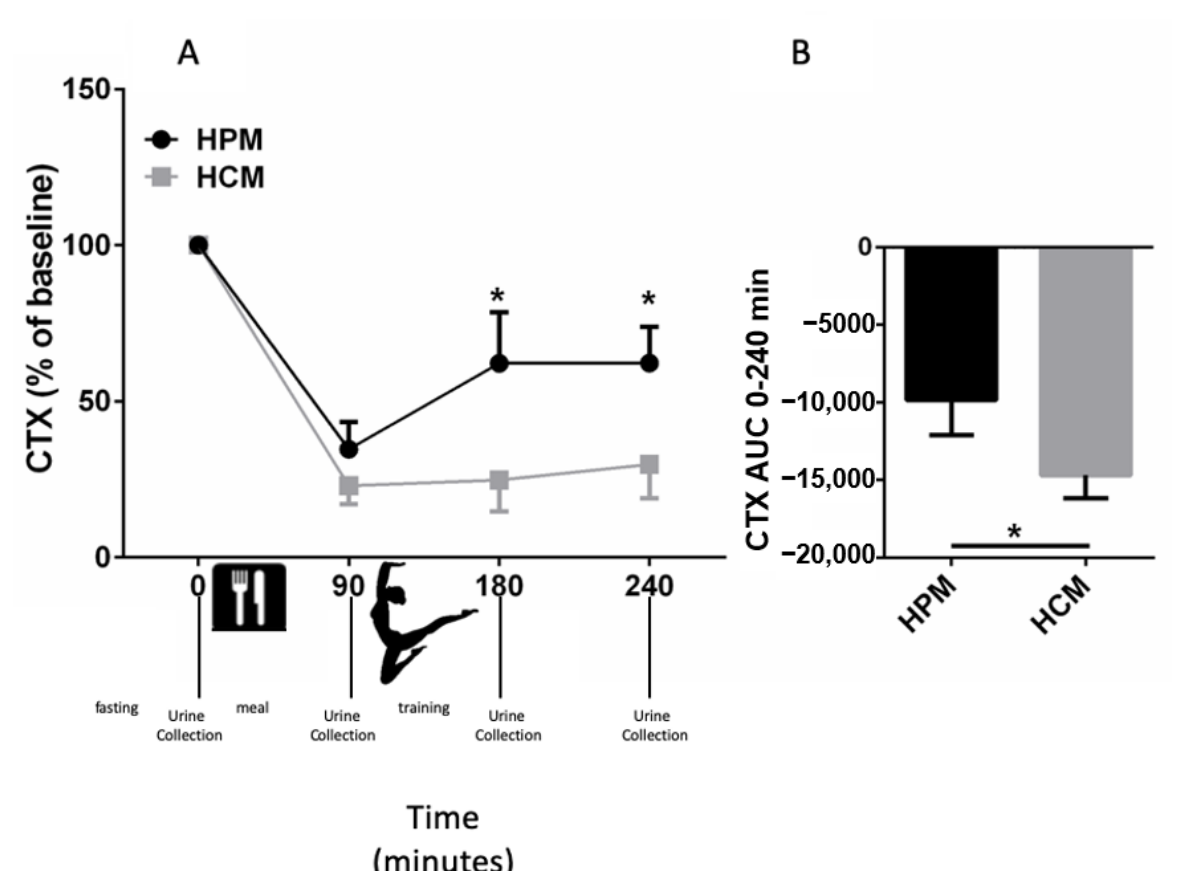
Figure 1. Effects of the pre-exercise meals on collagen type 1 (CTX) levels in female child artistic gymnasts. Urine samples were collected at 0, 90, 180 and 240 min. The meal was consumed after the first urine sample was collected (0 min). The duration of the sports session competition was 90 min and was simulated from time 90 to time 180 min. ( A ) Effects of the HPM and HCM on CTX levels. Mean CTX levels shown as percent of basal level ( B ) Mean area under the curve (AUC) 0 to 240 min of CTX. Error bars depict SEM. Asterisks (*) depict statistically significant differences. Statistical significance is set at p < 0.05. n = 14 in each group.